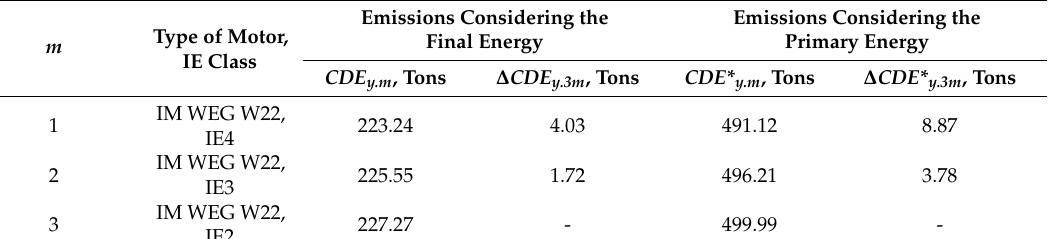
Table 5. CO 2 emissions calculation results. Table 4. Energy consumption and cost savings calculation results.